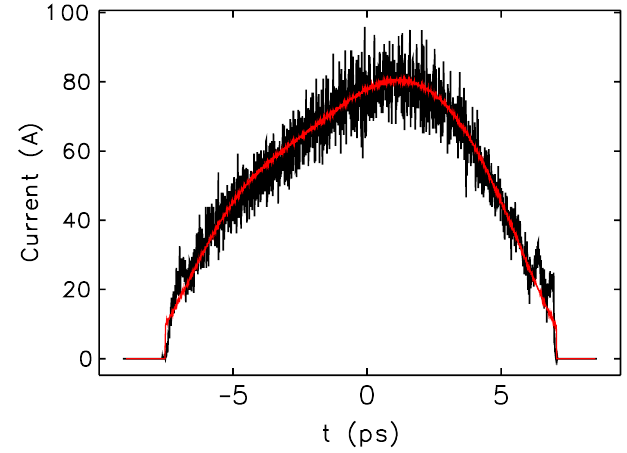
FIG. 1. (Color) Longitudinal density before (black) and after (red) smoothing and